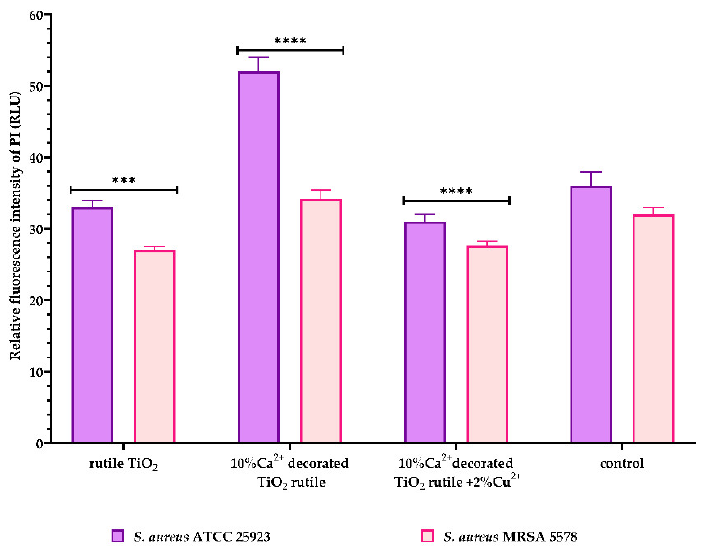
Figure 13. S. aureus strains’ inner membrane permeabilization measured by the detection of the fluorescence intensity of PI. All the data are shown as the mean ± SD of three independent experiments. p -values were determined via two-way ANOVA and Dunnett’s multiple comparisons tests (*** p = 0.003; **** p < 0.0001 vs. untreated